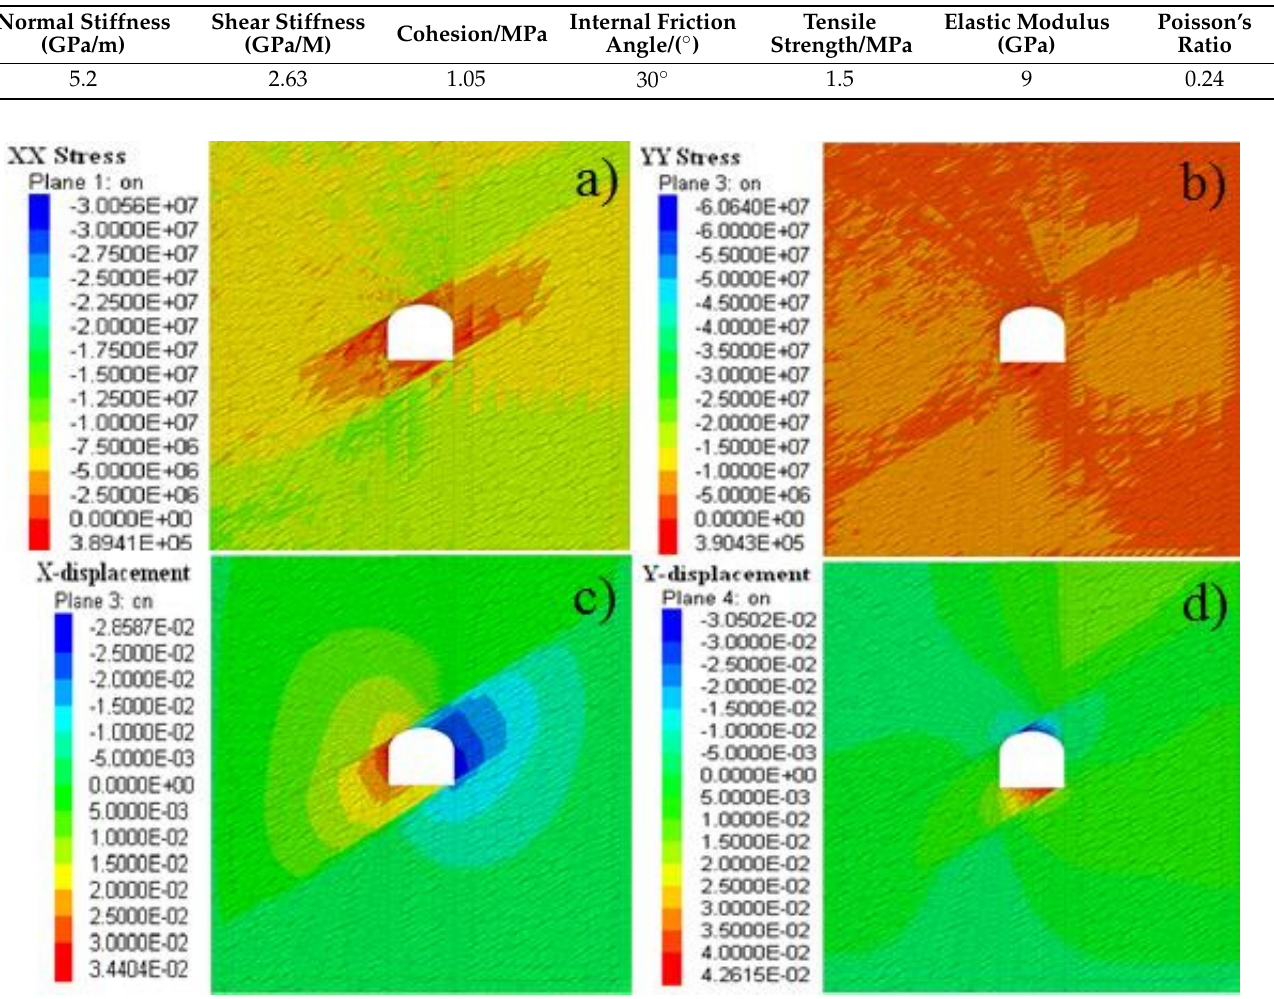
Table 2. The model calculation parameters.